Question: Express in one sentence what the figure is showing.
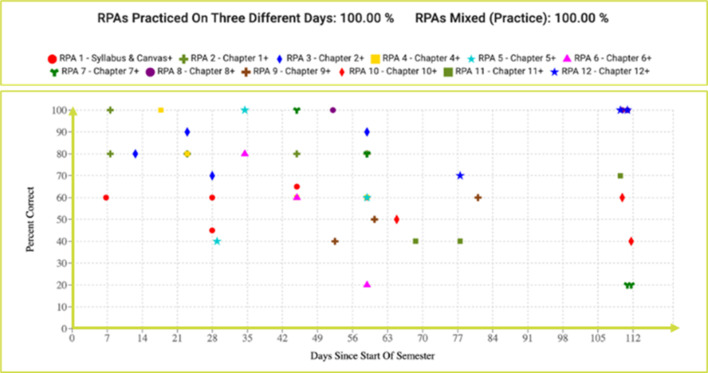
Answer: Student’s RPA graph. Note : Example RPA graph indicating each RPA attempt by a student since the start of the semester (X-axis) against the percentage correct for that attempt (Y-axis). Students can generate their RPA graph at any time during the semester using the U-Behavior LMS tool.